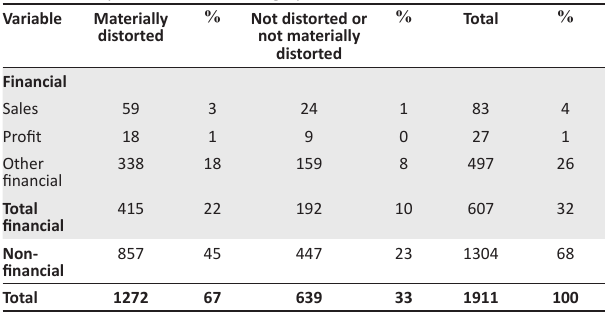
TABLE 5: Analysis of the number of graphs distorted.